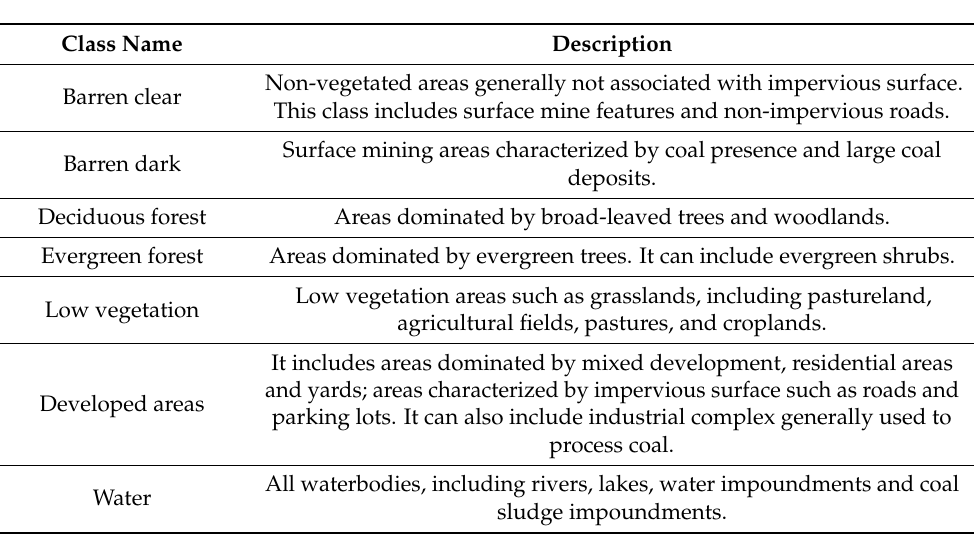
Table 3. The 1996 land cover classes definition.